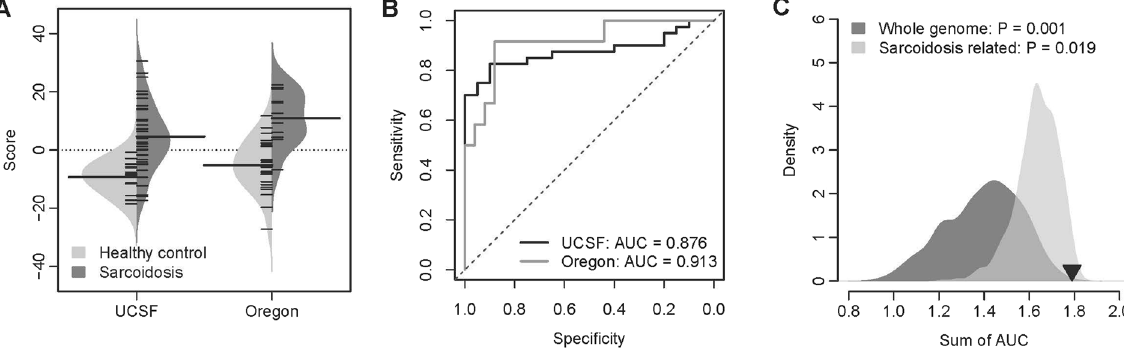
Figure 4. The performance of the 17-gene signature in the validation cohorts. ( A ) The 17-gene signature based severity score differentiates the sarcoidosis patients from the healthy controls in the UCSF and Oregon cohorts. The violin plot indicates the distribution of the severity score in each category. ( B ) The ROC curves of the 17- gene signature in classifying the subjects in the UCSF and Oregon cohorts. ( C ) Superior predictive power of the 17-gene signature compared with random gene set. The dark grey area shows the distribution of the sum of AUC (both the validation cohorts) for the 1,000 resampled gene signatures (with the identical size as the 17-gene signature) randomly picked up from human genome. The light grey area shows the distribution of the sum of AUC for the 1,000 resampled gene signatures randomly selected from the pool of the sarcoidosis related genes. The black triangle stands for the sum of AUC of the 17-gene signature. Right-tailed P -values of the sampling distribution were